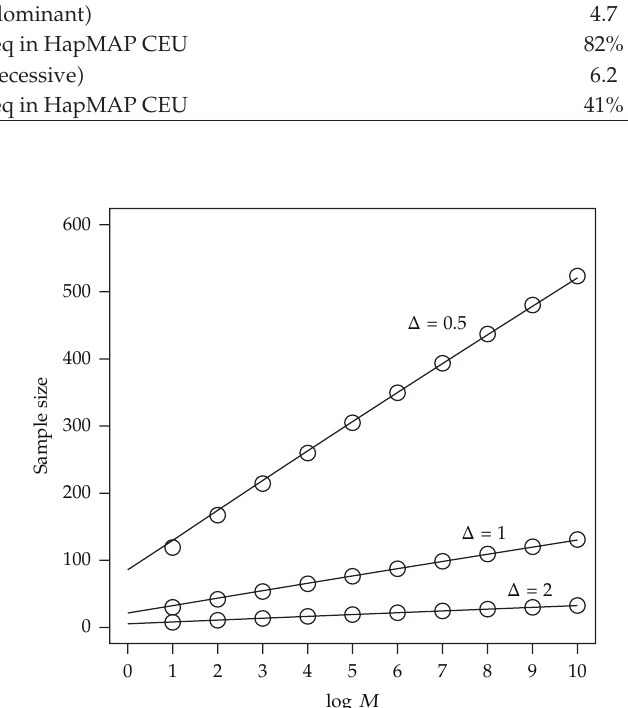
Figure 1: Sample size versus log M (cid:5) base 10 (cid:6) to detect e ff ect sizes Δ (cid:8) 0 . 5 , 1 or 2 with 1 − β (cid:8) 90% power at the familywise significance level α (cid:8) 5%, when Bonferroni adjustment is used. The open circles represent the sample sizes calculated based on exact normal quantiles (cid:5) 2.2 (cid:6) .